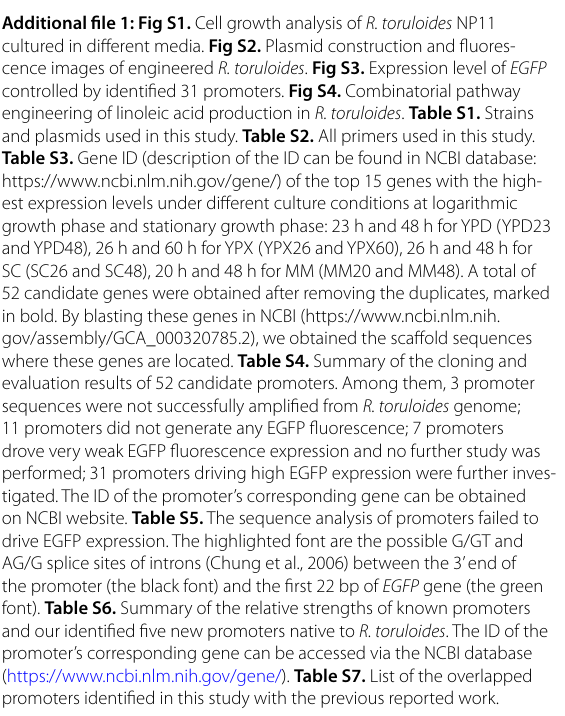
Table S3. Gene ID (description of the ID can be found in NCBI database: https://www.ncbi.nlm.nih.gov/gene/) of the top 15 genes with the high- est expression levels under different culture conditions at logarithmic growth phase and stationary growth phase: 23 h and 48 h for YPD